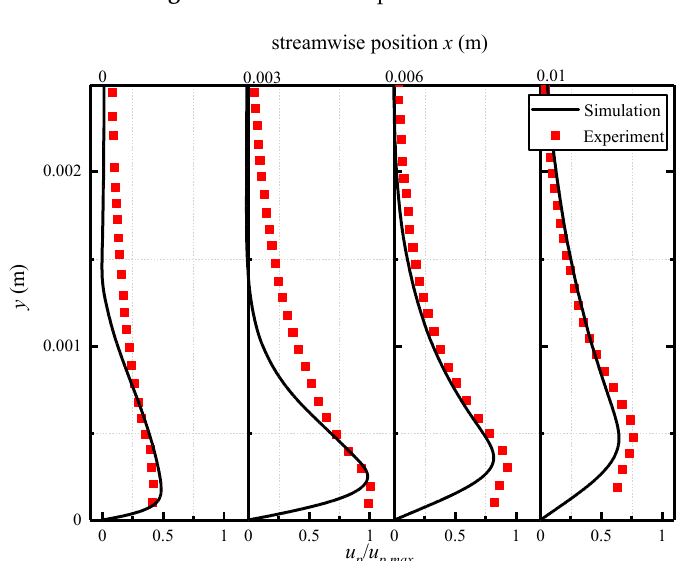
Figure 5. Velocity distribution at different streamwise positions.